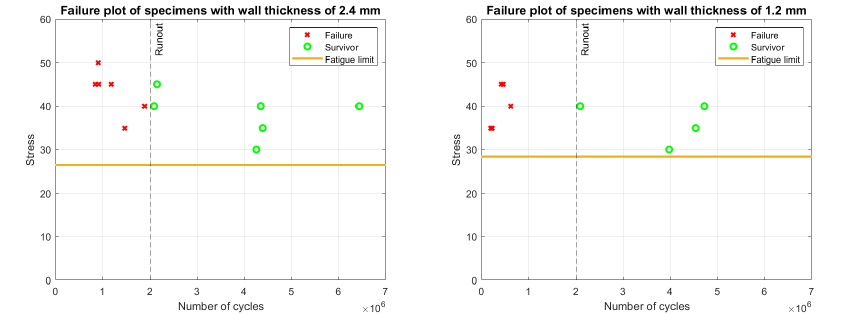
Figure 2. The failure trends recorded for stress-relief-treated specimens for the 2.4-mm and 1.2-mm- thick